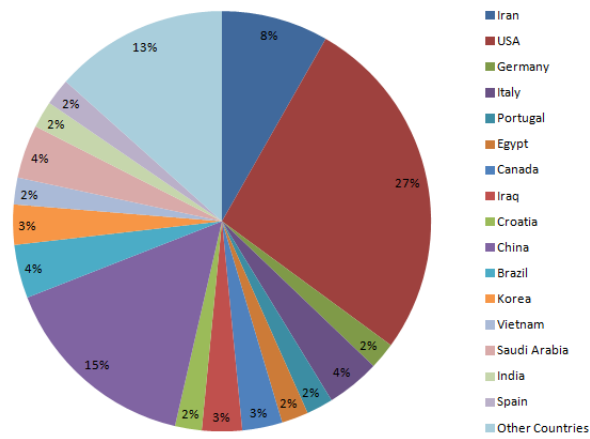
Figure 4. Chart of countries of the first author of the extracted research.